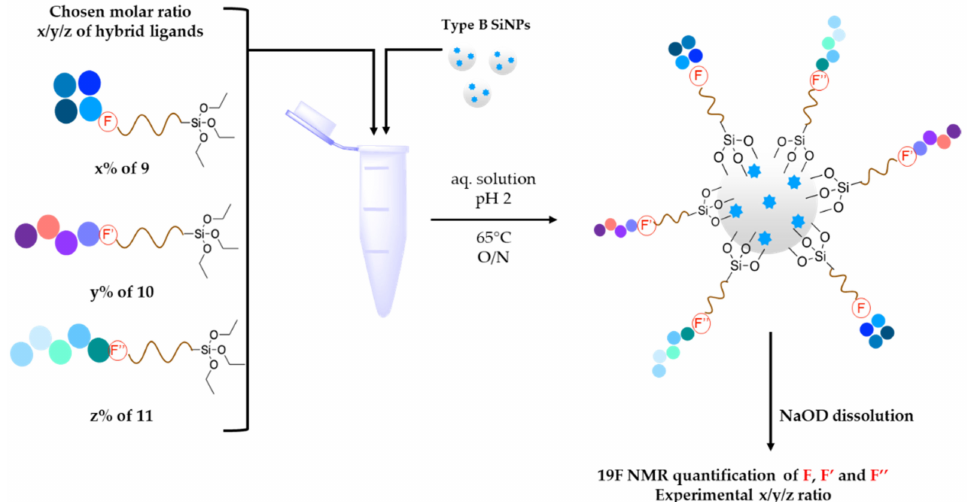
Figure 7. Preparation of multi-ligand fluorescent SiNPs with a simultaneous grafting of x/y/z ratio of hybrid ligands 9 , 10 , and 11